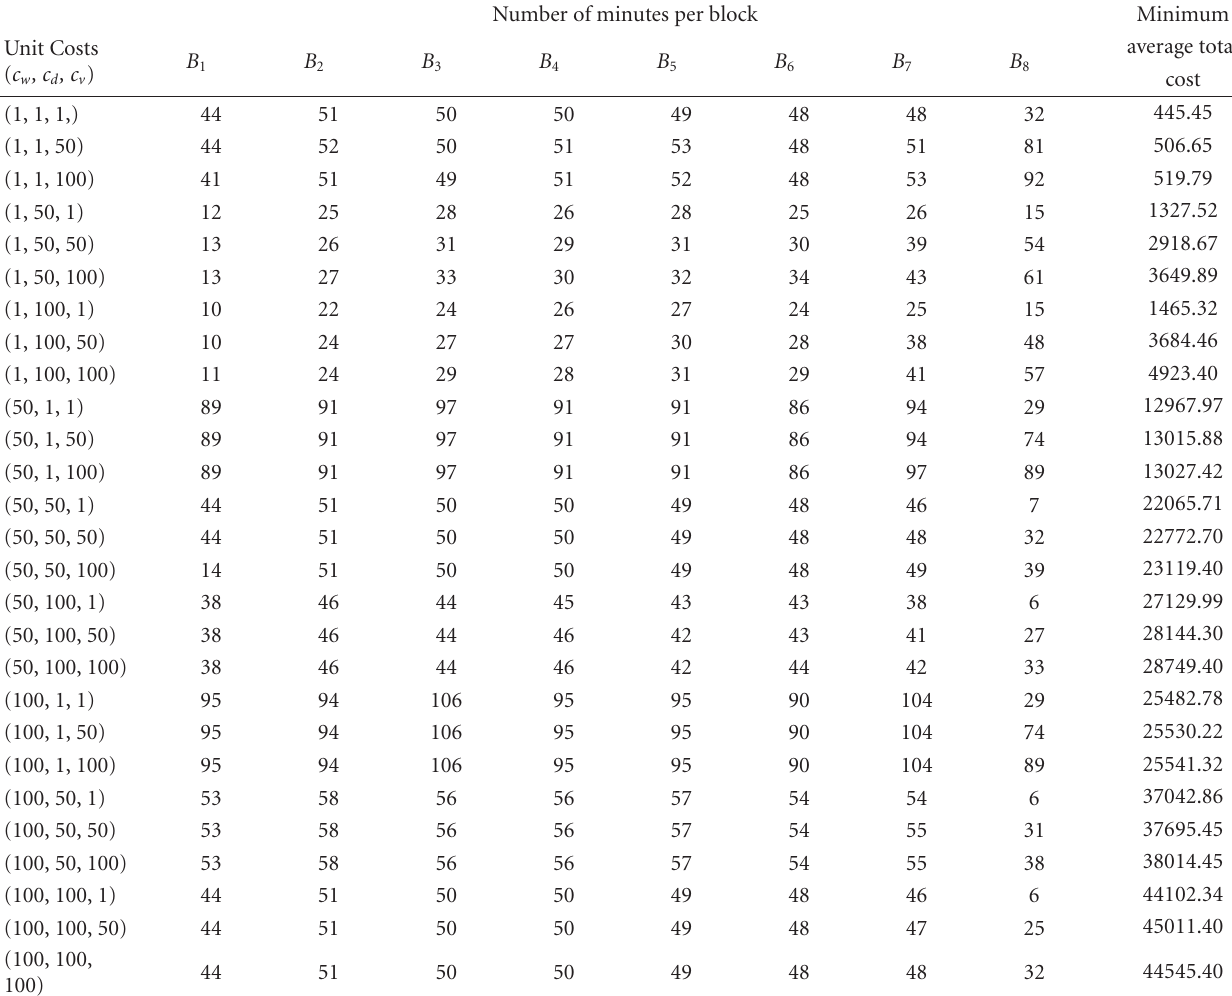
Table 2: Results for [3 3 3 3 3 3 3